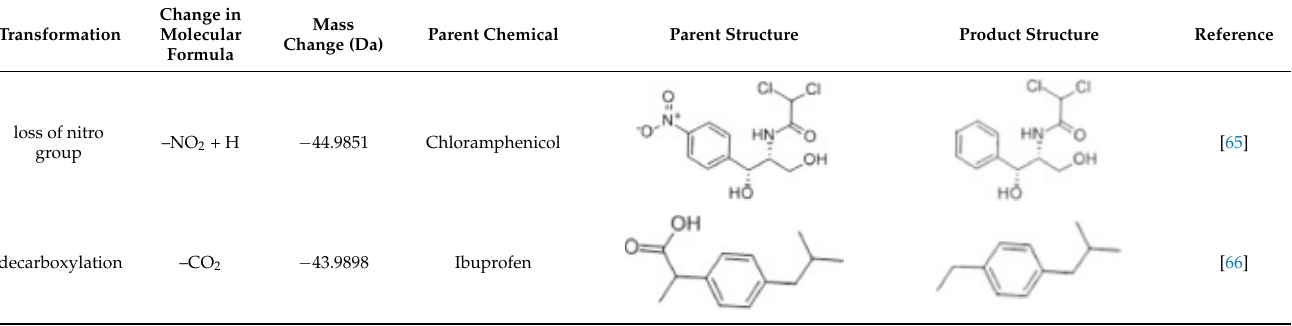
Figure 2. Contaminants and residues of mycotoxins, pesticides, pharmaceuticals, and brominated flame retardants may enter the environment via various routes, including water, sediment, soil, and groundwater. Hydrolysis, photolysis, metabolism, and microbial activity are the critical transformation mechanisms resulting in diverse TP formations that are broadly distributed. Table 2. Possible biological and chemical transformation reactions and associated mass changes. (Reprinted from [82], Copy right 2021, Elsevier ).